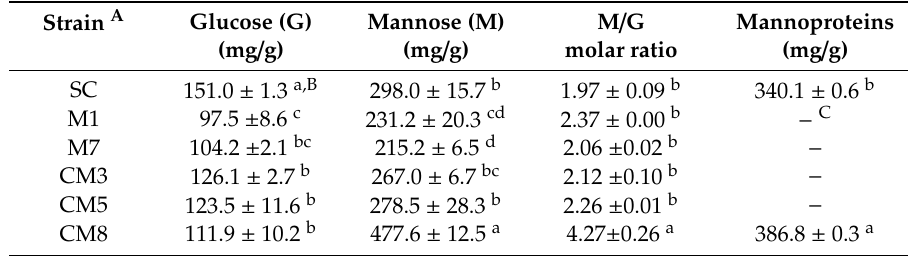
Figure 1. Images on yeast colonies on YPD citrate agar plates containing killer-9 toxin. SC = parent strain, S. cerevisiae BCRC 21685; M1 and M7 = mutants by UV light; CM3, CM5, and CM8 = mutants by ethyl methane sulfonate (EMS); D1 to D4 = dilutions of 10 − 1 to 10 − 4 for yeast suspensions (initially ~10 8 ). Table 1. Sugar compositions and mannoprotein contents in the cell walls of S. cerevisiae and its mutant